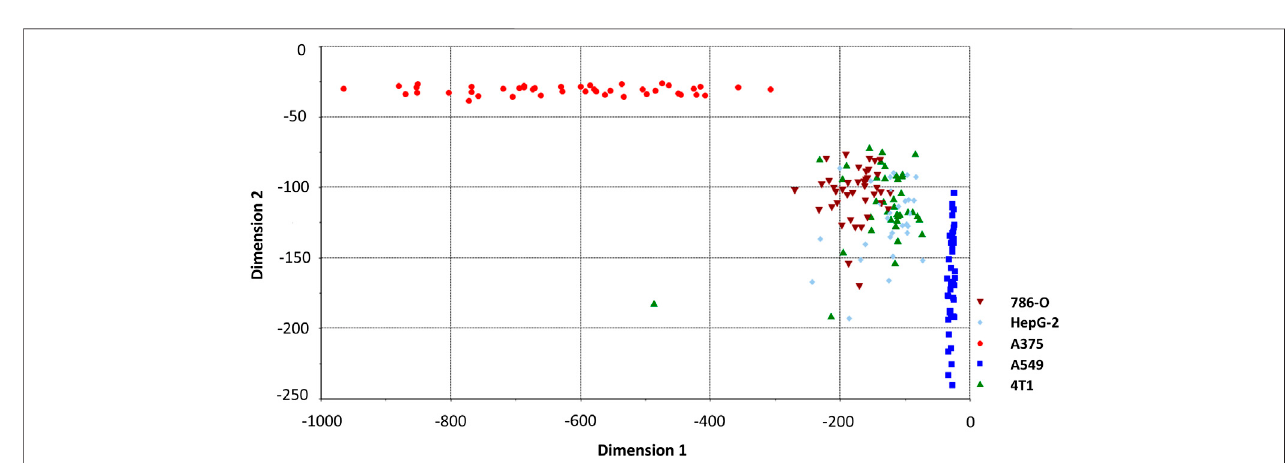
FIGURE 6 | QDA classi fi cation model classifying spectrum of cancer cell lines. Two of fi ve dimensions are plotted.